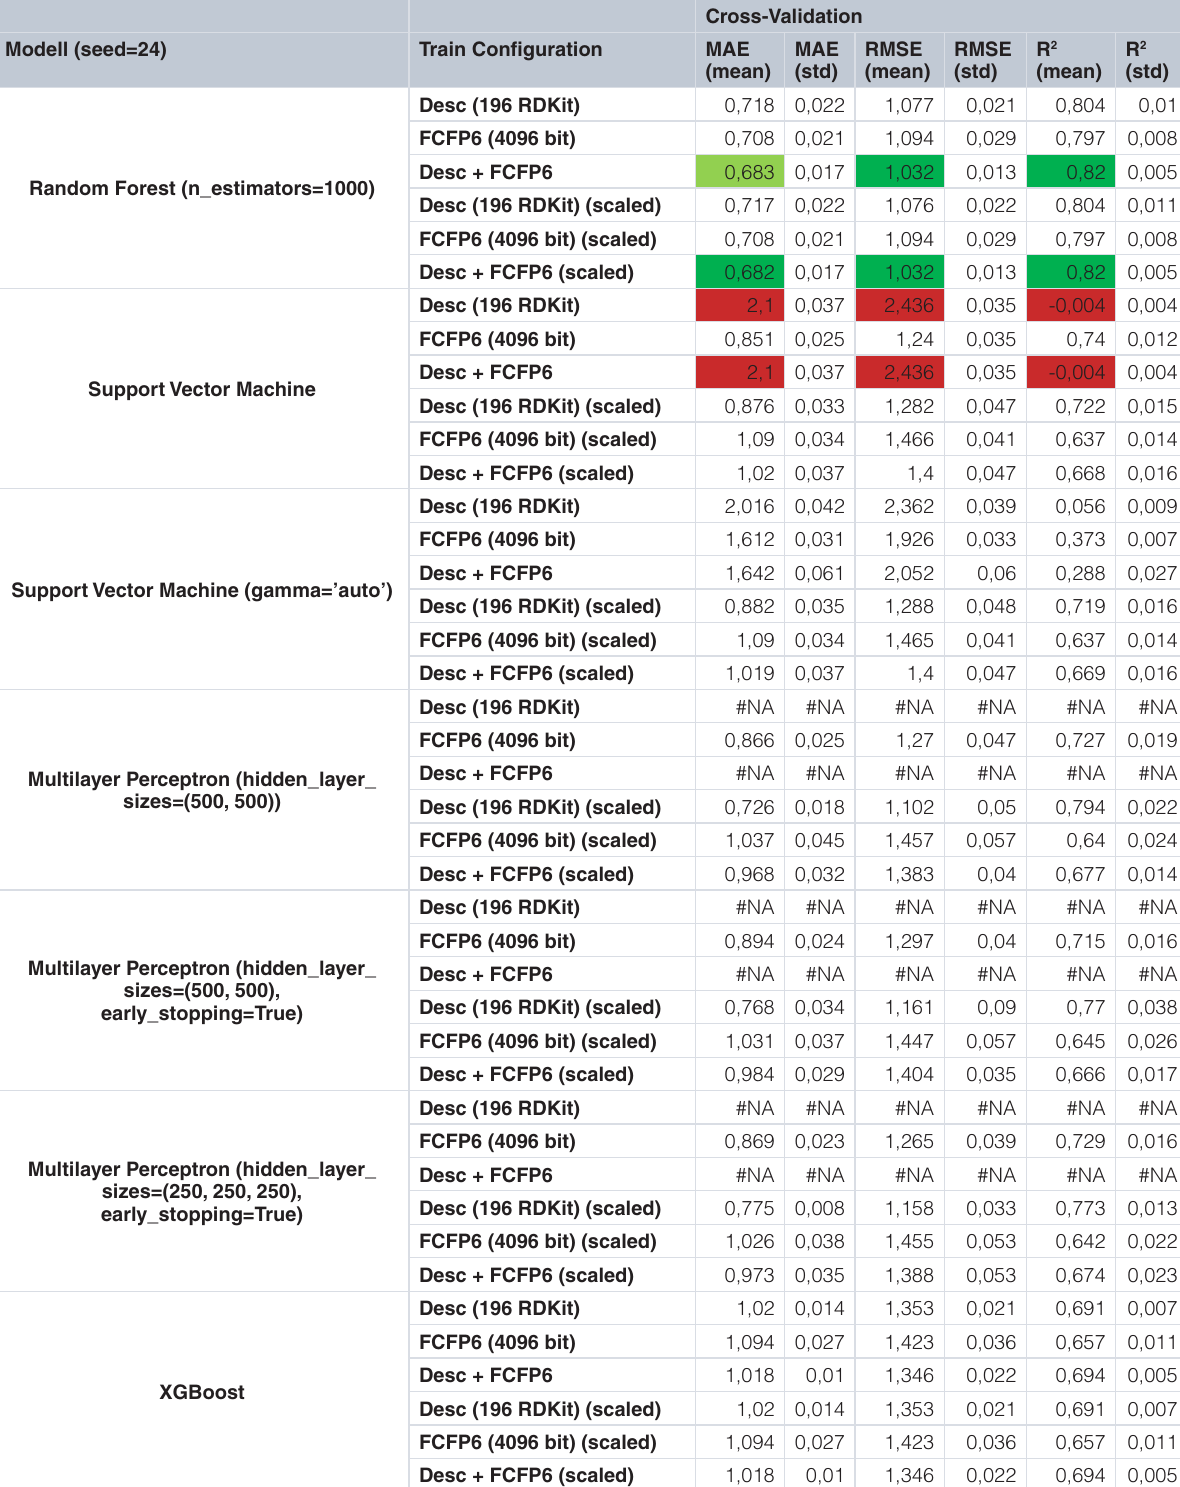
Table 1. Statistics of the five-fold cross-validation of the machine learning models. The two best and worst performing models are highlighted in green and red. For those neural networks where the values were specified as “not available” (“#NA”), the weights could not be optimized properly due to the large value range of the RDKit descriptors, so training failed